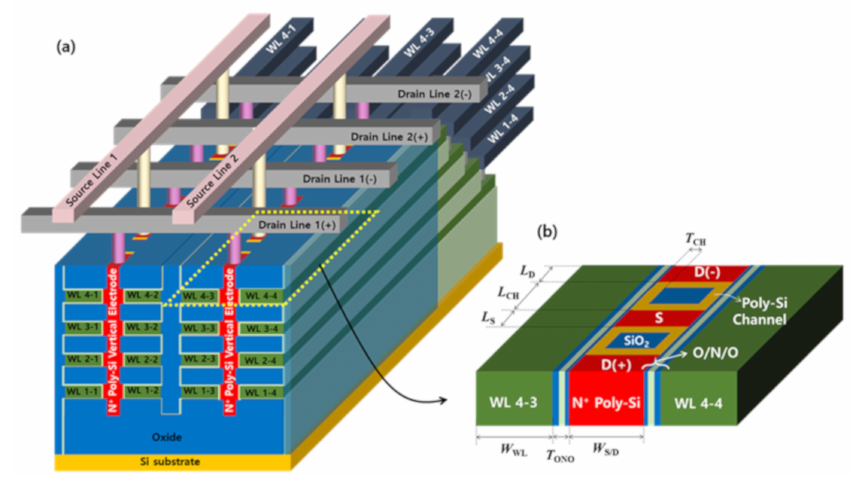
Figure1. 3-Dsynapsearraystructure[11]. ( a )3-Dstackedsynapsedevice; ( b